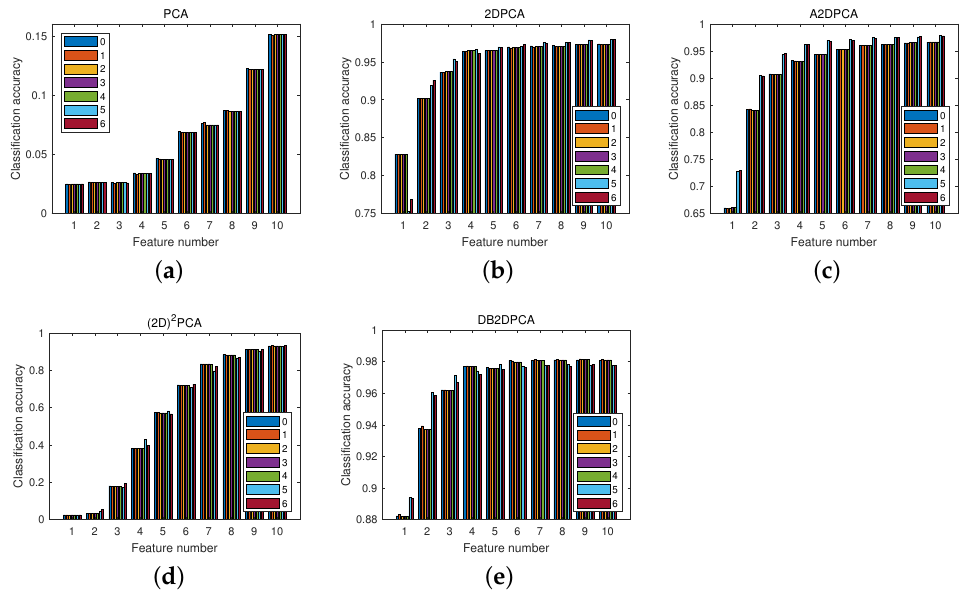
Figure 9. The average classification accuracies on Extended Yale B face database and its six reordered databases with CRC as the classifier. ( a ) PCA. ( b ) 2DPCA. ( c ) A2DPCA. ( d ) ( 2D ) 2 PCA. ( e )